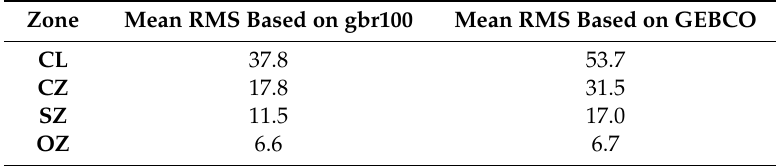
Table 4. Mean root mean square (RMS) of sea level anomalies (SLAs) based on bathymetry models gbr100 and GEBCO in the test area